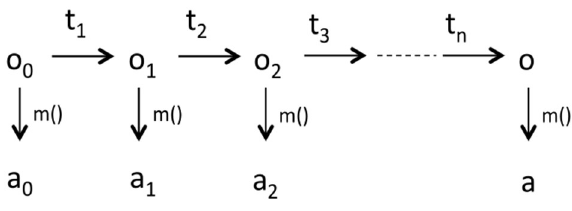
Figure 2. Mirror history.